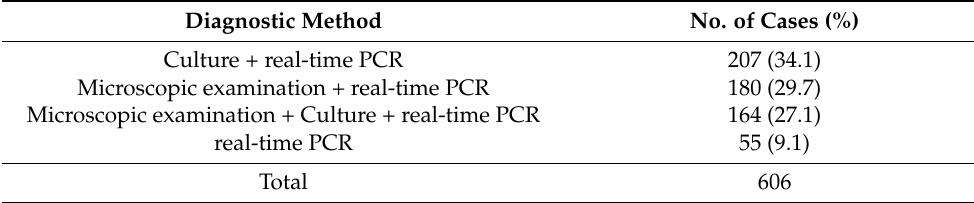
Table 3. Detection of D. fragilis by each single diagnostic